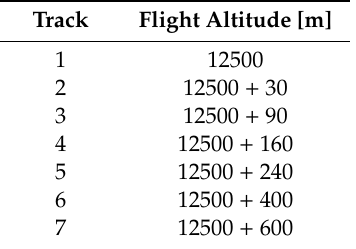
Table 1. TomoSAR acquisition